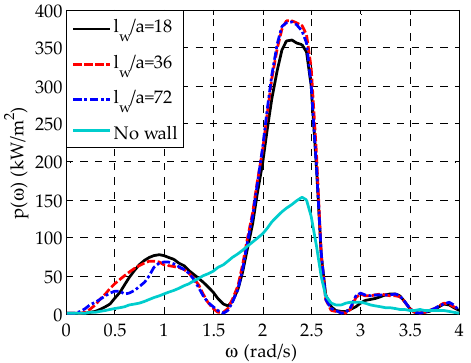
Figure 12. E ff ect of l w / a on p ( ω ) of the array with semi-immersed oblate spheroidal WECs for c / a = 3 Figure 12. Effect of 𝑙 (cid:3050) /𝑎 on 𝑝(𝜔) of the array with semi-immersed oblate spheroidal WECs for and l bet / a = 𝑐/𝑎 = 3 and 𝑙 (cid:3029)(cid:3032)(cid:3047) /𝑎 = 4 .